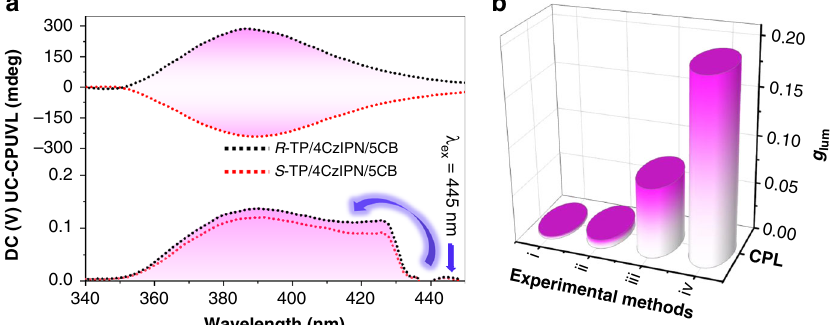
Fig. 5 UC-CPUVL of R ( S )-TP/4CzIPN in N*LC. a UC-CPUVL spectra of R ( S ) - TP/4CzIPN in N*LC with incident excitation of the 445nm CW laser (A 445 nm short-pass fi lter was used). b Collection of luminescence dissymmetry factor g lum of (i) R -TP in toluene solution excited at 290 nm ([ R- TP] = 0.01 mM); (ii) R -TP/4CzIPN in toluene solution excited by 445 nm CW laser ([ R -TP] = 3 mM, [4CzIPN] = 0.1 mM); (iii) R -TP in N*LC excited at 290 nm ( R - TP/5CB = 10 wt%); (iv) R -TP/4CzIPN in N*LC excited by 445nm CW laser ( R -TP/5CB = 10 wt%, 4CzIPN/ R -TP = 3